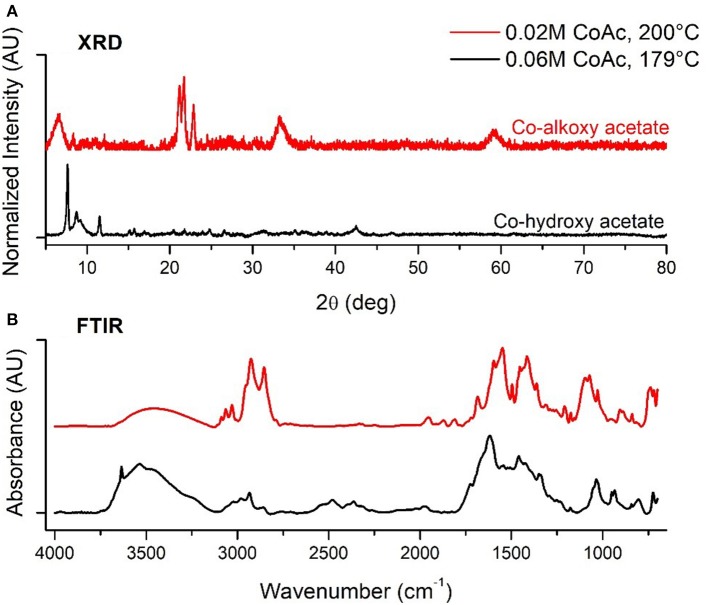
(A) XRD and (B) FTIR of Co alkoxy and hydxroxy acetate structures formed at low temperature.